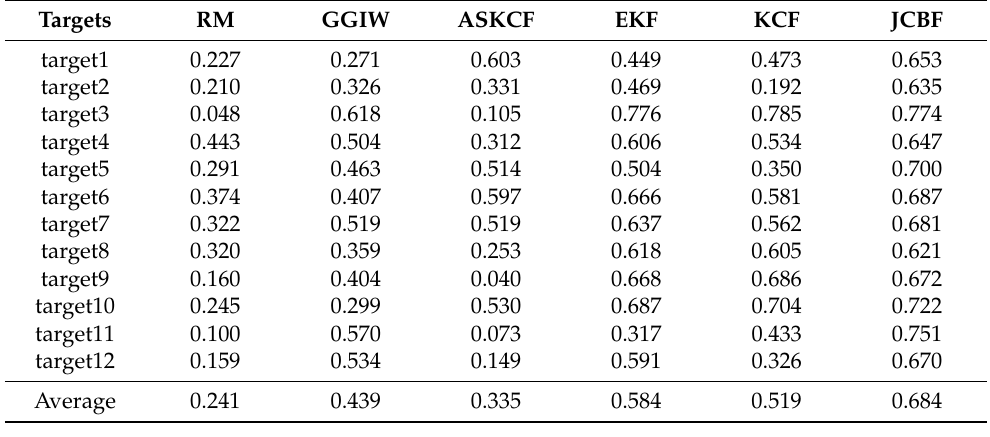
Table 7. Average overlap precision ( OP ∈ [ 0,1 ] ↑ , ↑ means higher is better).